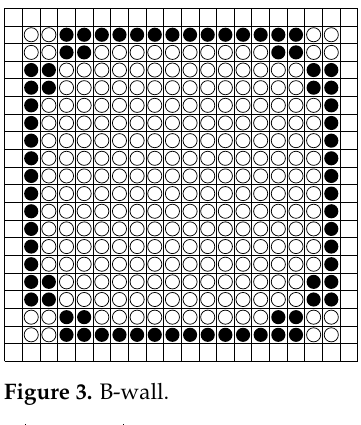
Figure 3. B-wall.